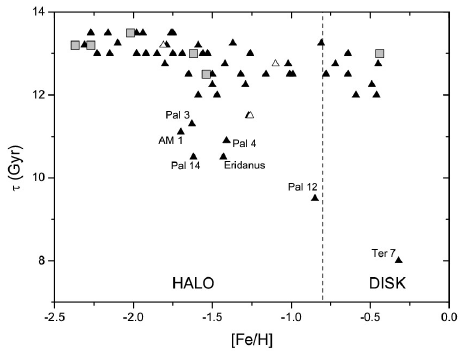
Figure 10: Core-collapse time in function to W 0 . The t cc values are estimated as in Quinlan